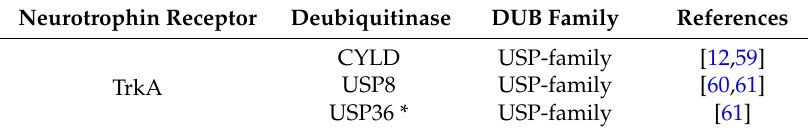
Table 2. Deubiquitinating enzymes that participate in the removal of ubiquitin on the TrkA